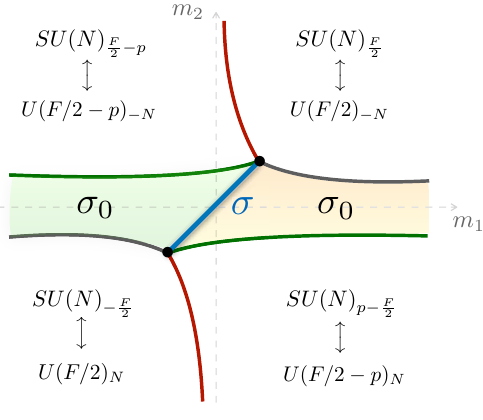
Figure 6 . Phase diagram of SU ( N ) 0 + p ψ 1 + ( F − p ) ψ 2 . The transition lines with the same color are described by the same theories, up to a time-reversal transformation.